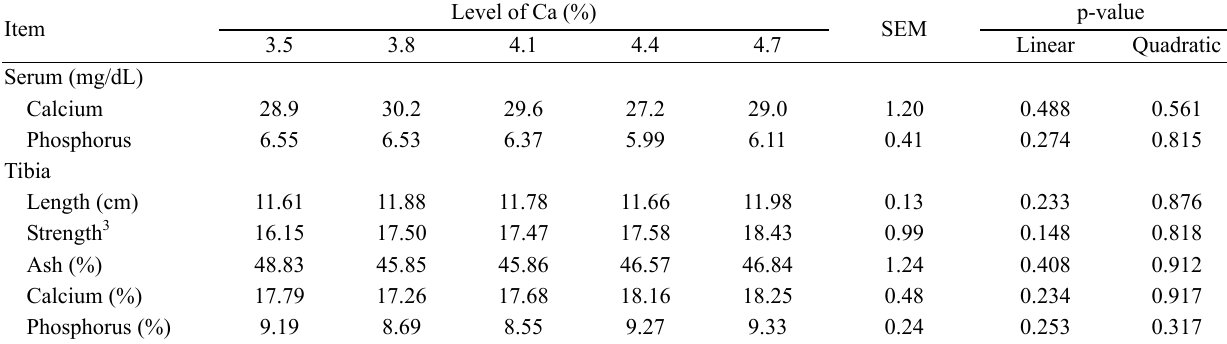
Table 5. Effect of graded levels of dietary calcium on overall calcium status in serum and tibia 1,2